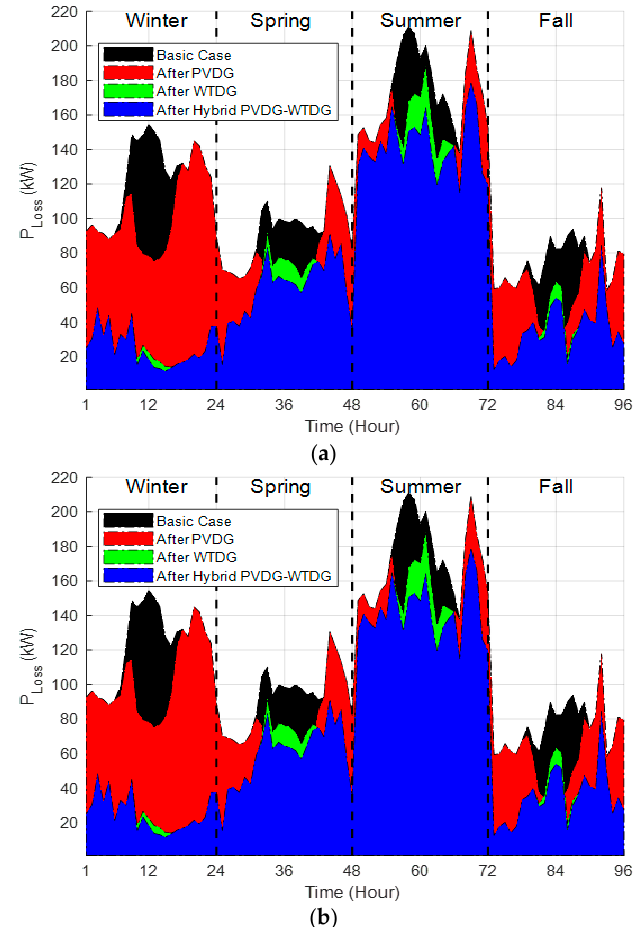
Figure 10. The seasonal total active power losses variation: ( a ) IEEE 33-bus; ( b ) IEEE 69-bus.